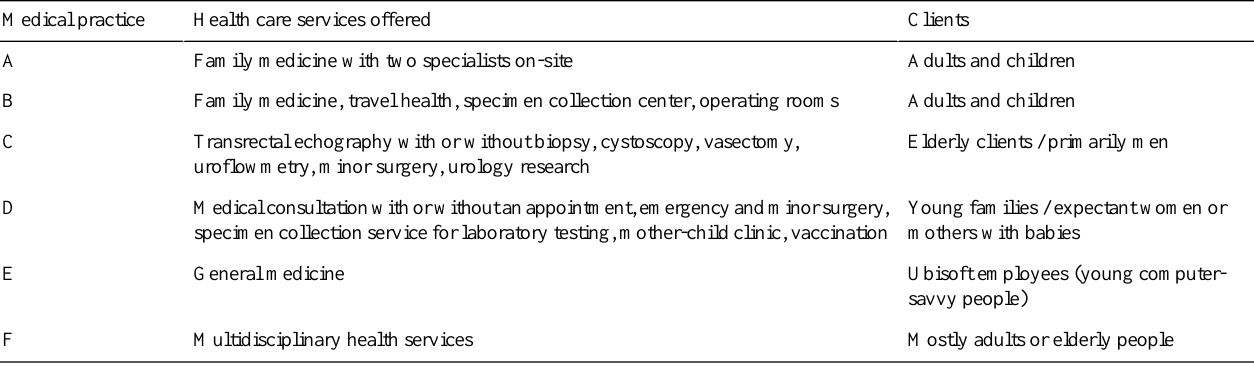
Table 1. Profile of the medical